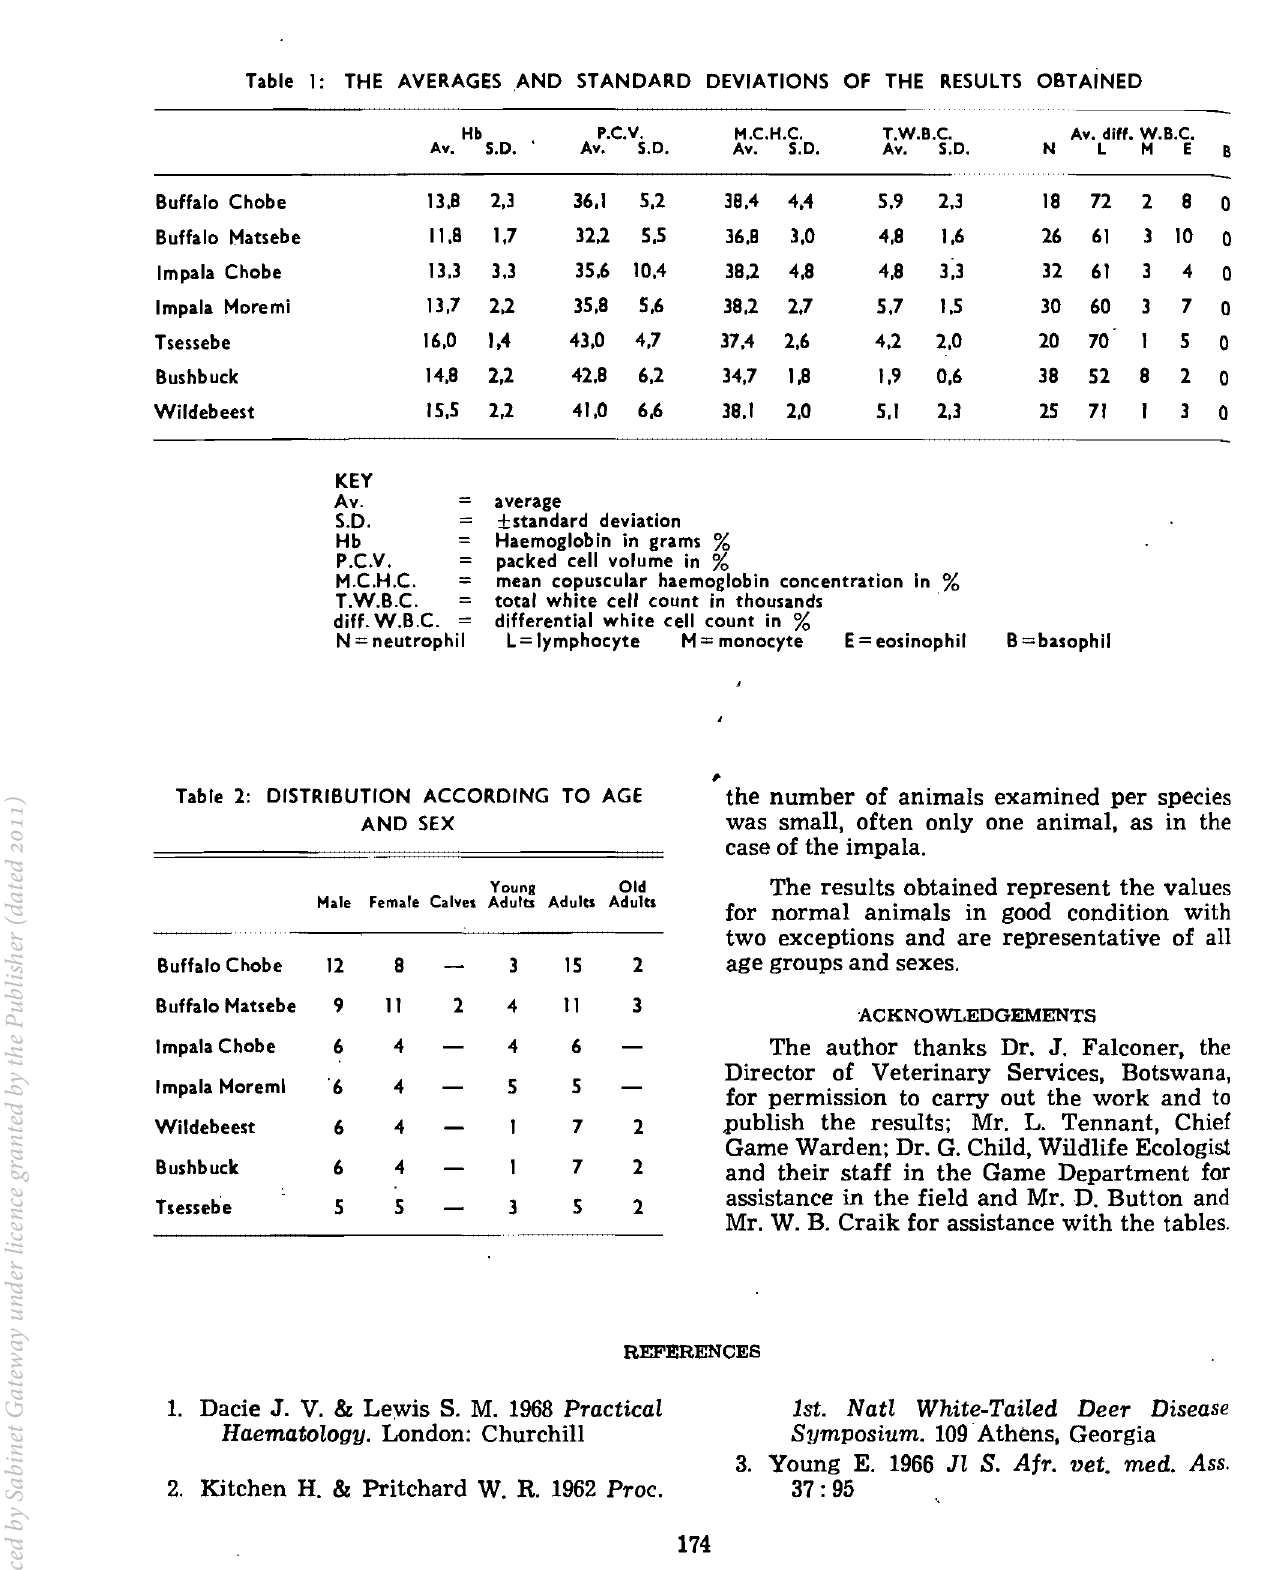
Wildebeest a KEY Av. average S.D. ±standard deviation Hb Haemoglobin in grams % P.C.V. packed cell volume in % M.C.H.C. mean copuscular haemoglobin concentration in % T.W.B.C. total white cell count in thousands diff. W.B.C. differential white cell count in % N = neutrophil L = lymphocyte M= monocyte E = eosinophil B =basophil